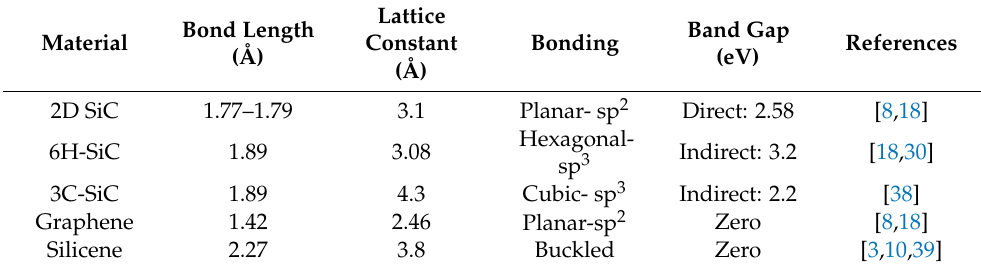
Table 1. Structural characteristics of 2D SiC and related